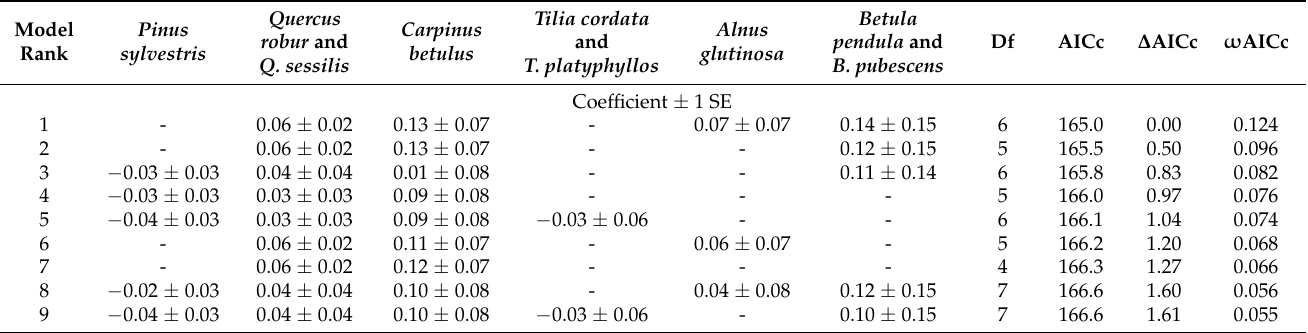
Table 5. The highest-ranking models predicting species richness of primary cavity nesters in the studied forest based on (coefficients ± 1 SE): total basal area of trees thicker than 20 cm DBH. The AICc weight ( ω AICc) for a given model indicates the probability it is the most parsimonious model.